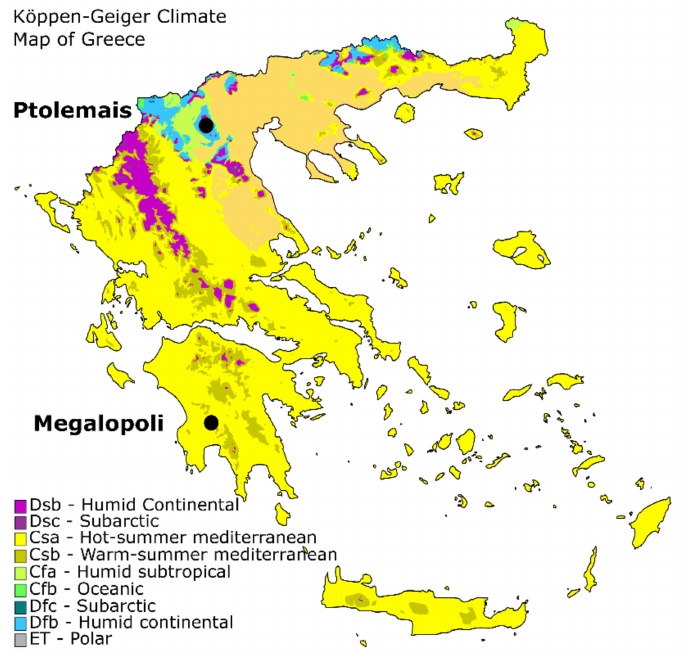
Figure 2. Geographical distribution of lignite mining areas and Koppen–Geiger classification for Greece